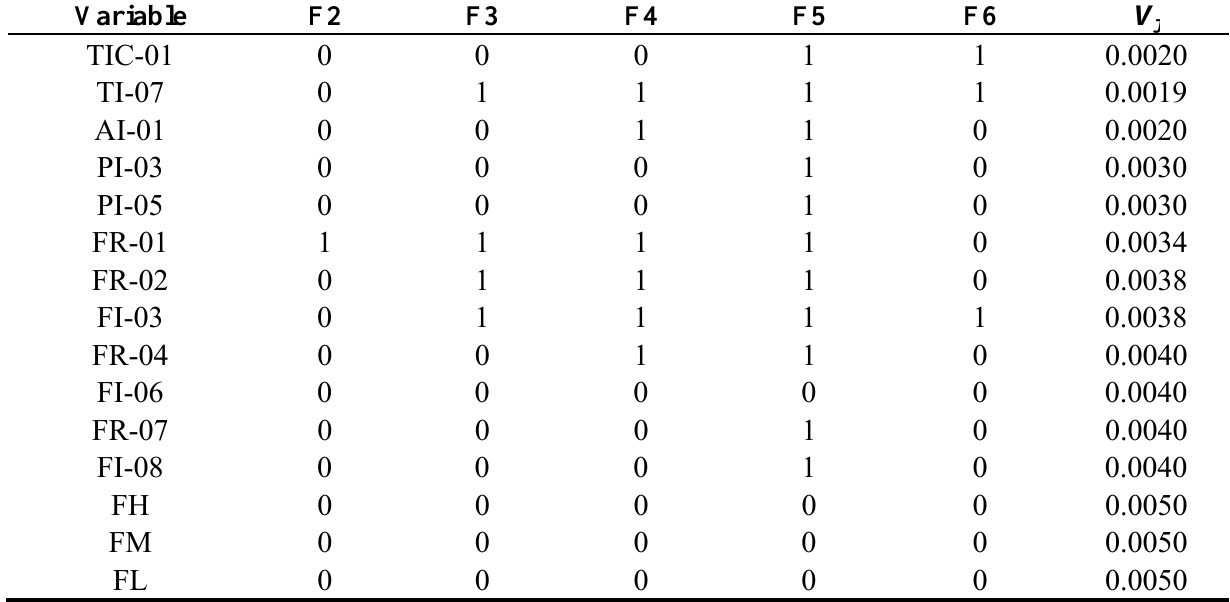
Table 3. Reachability from faults to